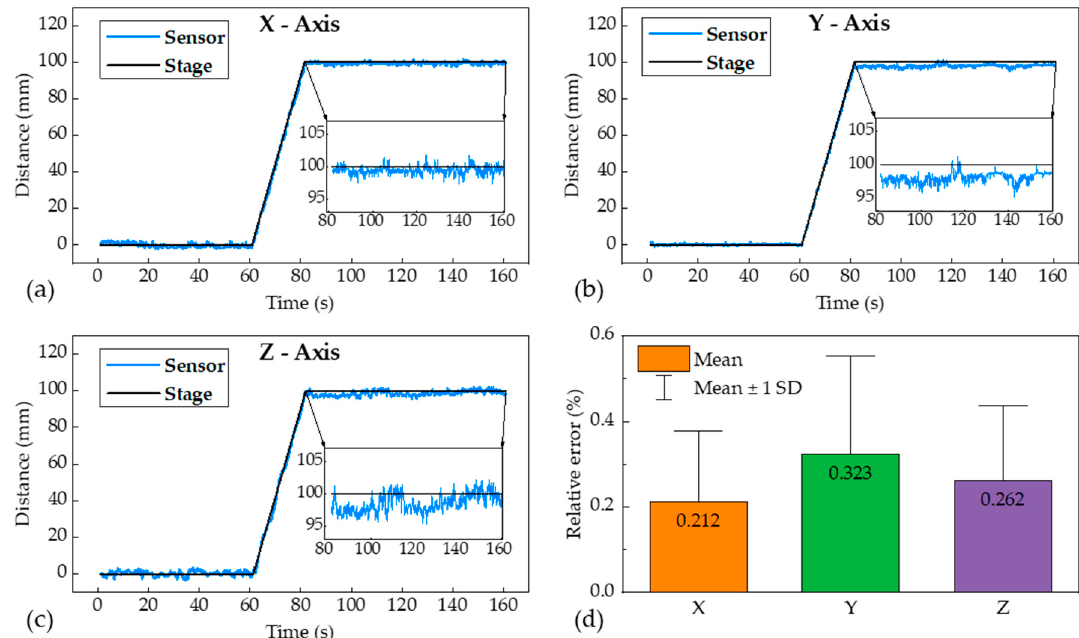
Figure 6. Actual movement (black line) of the probe by the XYZ stage and the measured position data (blue line) of the probe by the ultrasonic sensors along the ( a ) X-, ( b ) Y-, and ( c ) Z-axes. ( d ) The relative error of the measured position data of the ultrasonic sensors in each axis (calculated from ( a – c )).